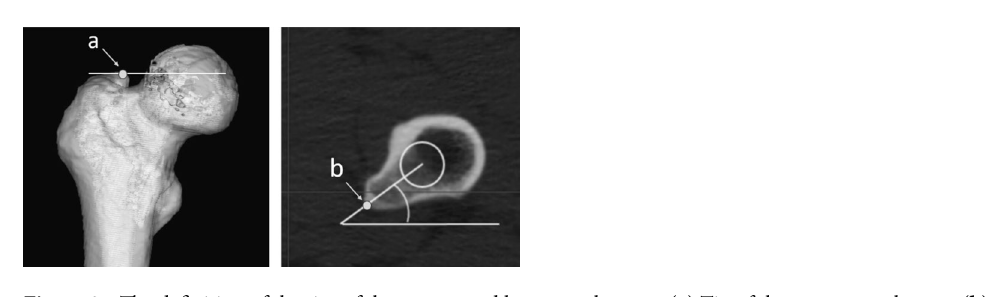
Figure 2. The definition of the tips of the greater and lesser trochanters. ( a ) Tip of the greater trochanter; ( b ) the tip of the lesser trochanter was defined as in the study by Unlu et al. 13